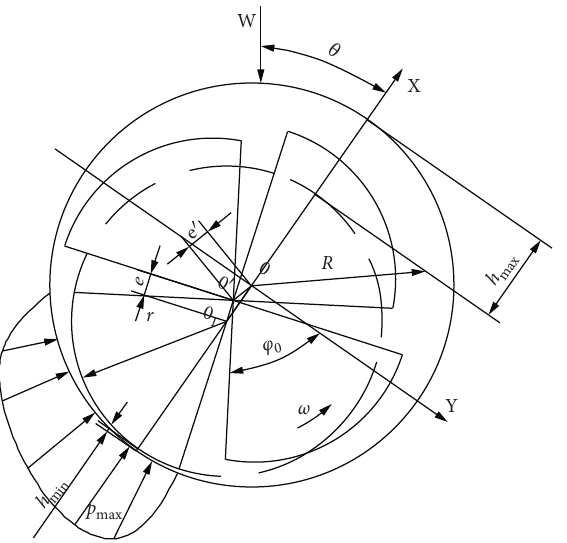
Figure 4: Axial forces of bearing 1 and bearing 2 and resultant force of magnetic bearings acting on the rotor in different axial positions.